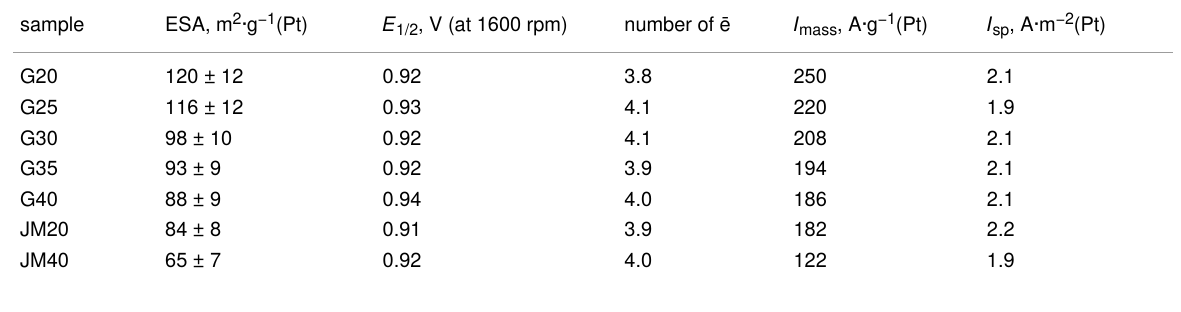
Table 2: Parameters characterizing the electrochemical behavior of Pt/C catalysts. sample